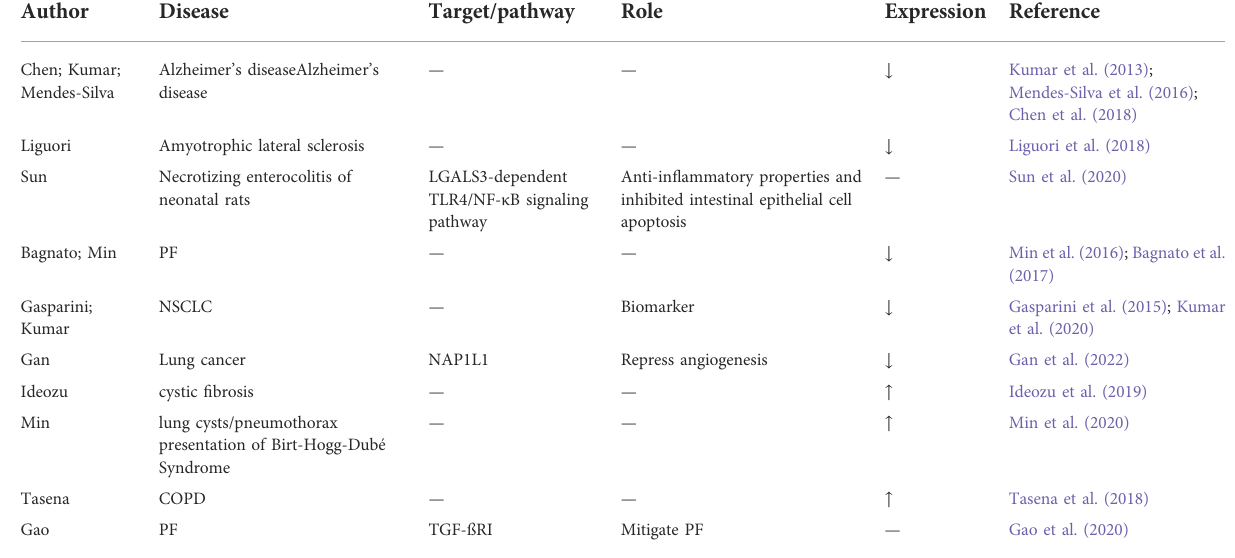
TABLE 4 The roles of let-7d-5p in lung